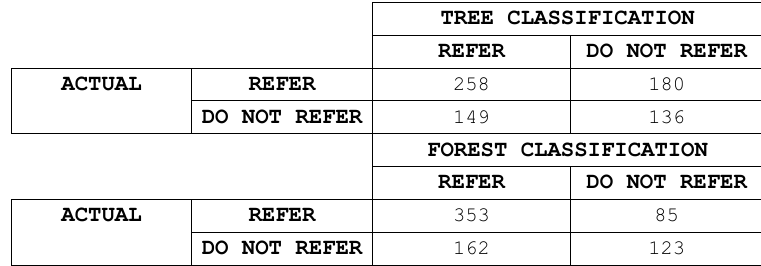
Table 4. Four color slope value